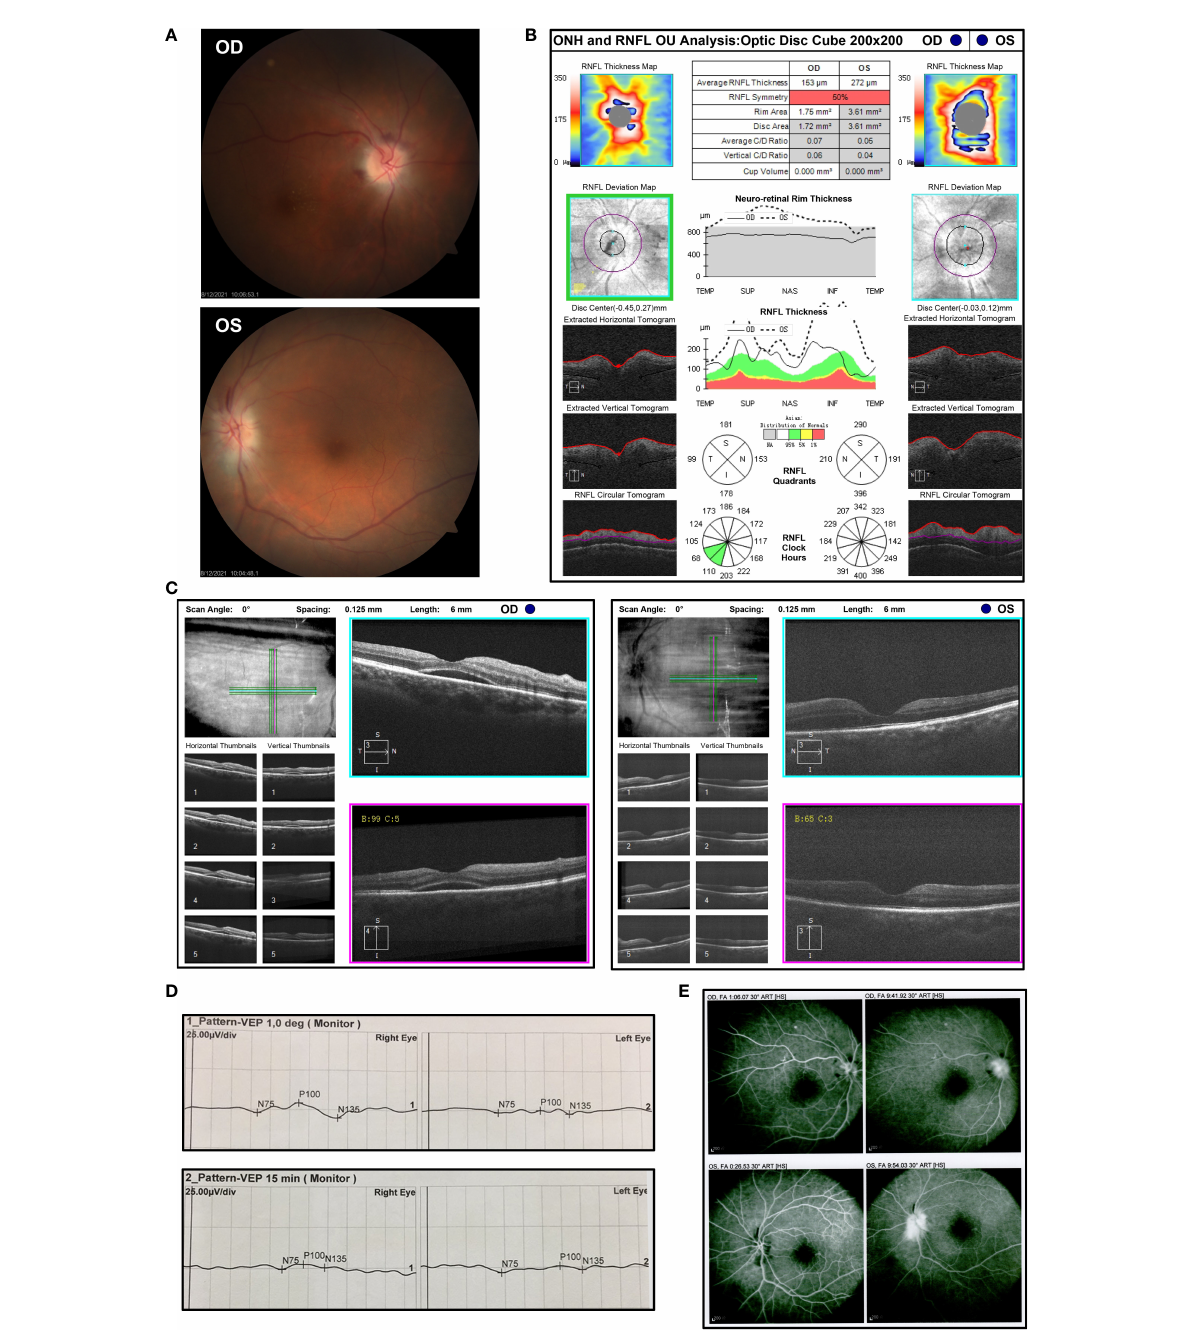
FIGURE 2 The ophthalmic examination of the patients with bilateral optic neuropathy after three cycles of sintilimab-containing therapy (A) Fundus photography displayed obvious optic disc edema in both eyes with macular edema in his right eye and parapapillary linear hemorrhage in his left eye after the third cycle of sintilimab plus chemotherapy on 12 August 2021. OD, oculus dexter; OS, oculus sinister. (B) Measurements of the thickness of retinal nerve fi ber layer (RNFL) by optical coherence tomography (OCT) on 5 August 2021. (C) Macular OCT showed subretinal fl uid in the right eye on 5 August 2021. (D) Visual evoked potential (VEP) was measured on 6 August 2021 and showed prolonged P100 latency and decreased P100 amplitude at 60 and 15 arcmin in both eyes. (E) Fundus fl uorescein angiography (FFA) indicated optic disc fl uorescence leakage at the late stage and low fl uorescence perfusion at the early stage in both eyes on 12 August